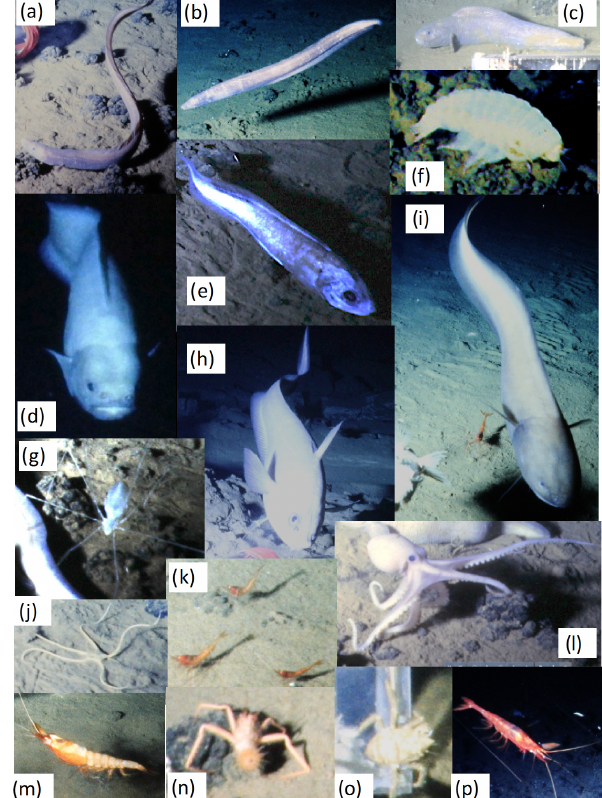
Figure 6. Representative images of OTUs identified using baited cameras in the DISCOL region. Photos taken in 1989 and 1992. (a) Illypohis sp. (b) Synaphobranchidae. (c) Pachycara nazca . (d) Barathrites iris . (e) Leucicorus sp. (f) Large amphipod,